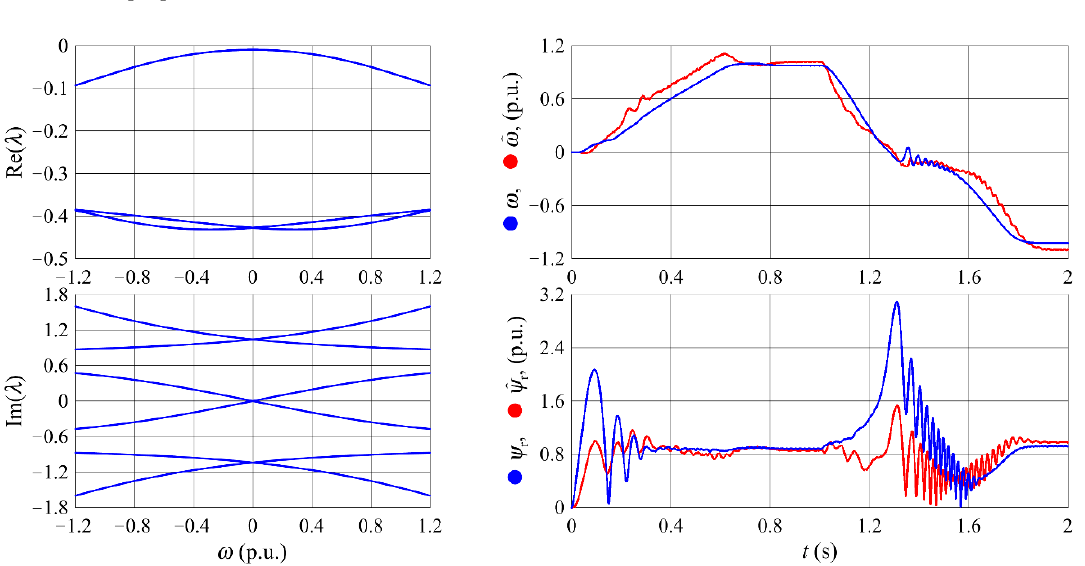
Figure 9. The eigenvalues and simulation results obtained for the modified integral observer.